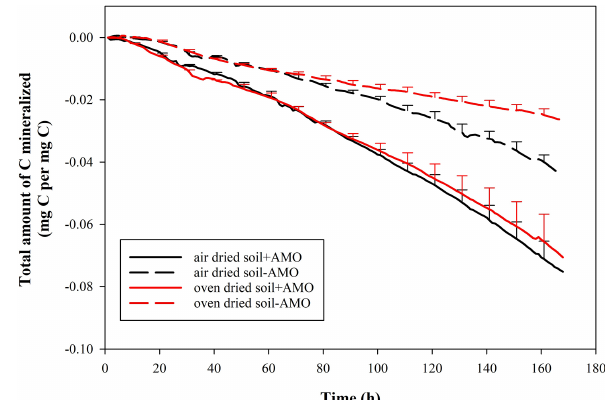
Figure 5. Cumulative amount of C mineralized during incubation with oven-dried soil (red) and air-dried soil (black), with addition of AMO (full line) and without addition of AMO (dashed line). Standard errors were calculated based upon three repetitions with different river water